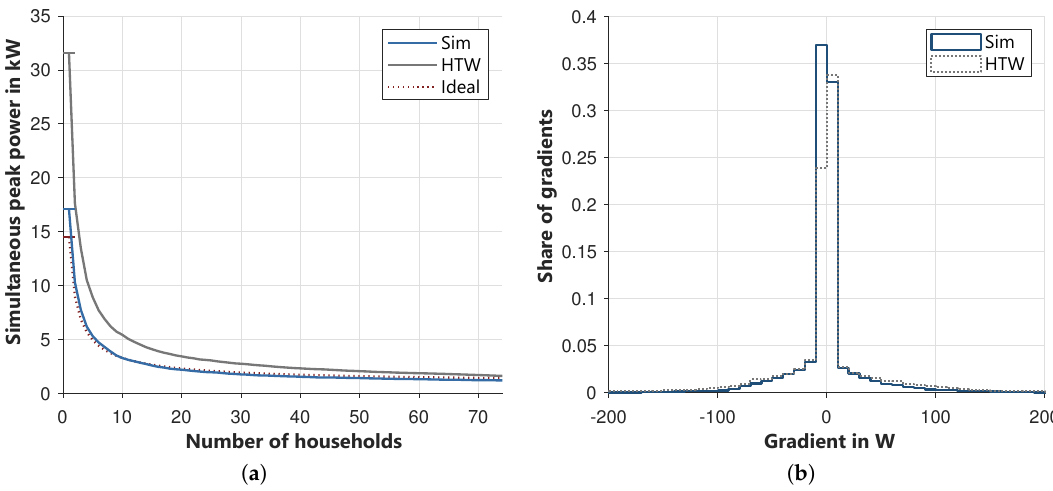
Figure 12. ( a ) Simultaneous peak power depending on the number of households, ( b ) distribution of gradients in the range − 200 W to 200